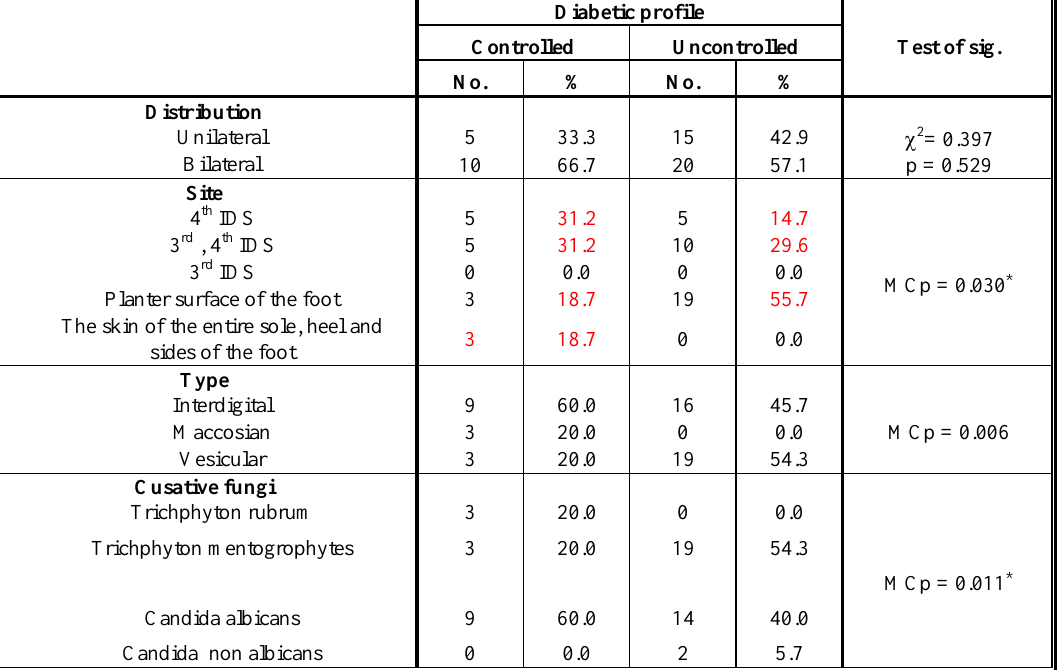
Diabetic profile Test of sig. Controlled